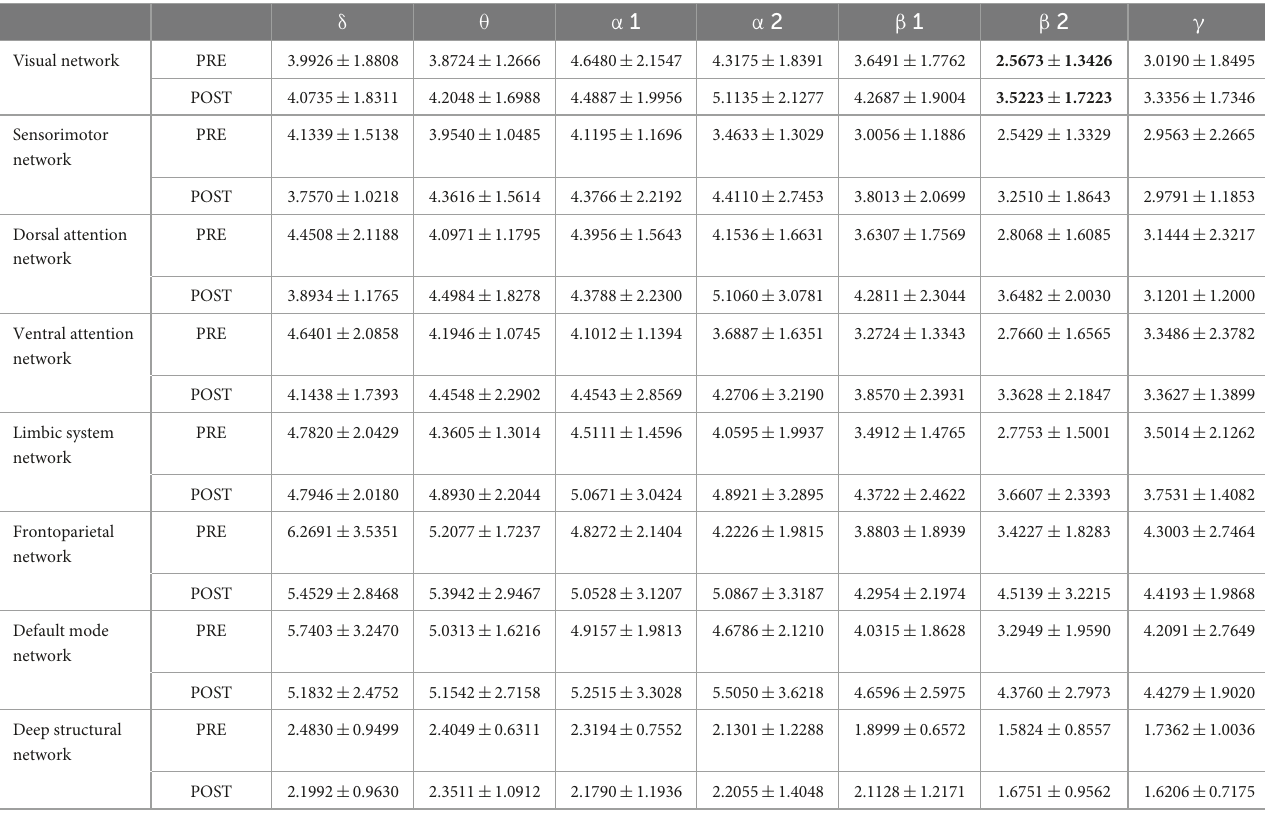
TABLE 4 Rhythmic energy values on large-scale brain networks before and after exhaustive exercise.